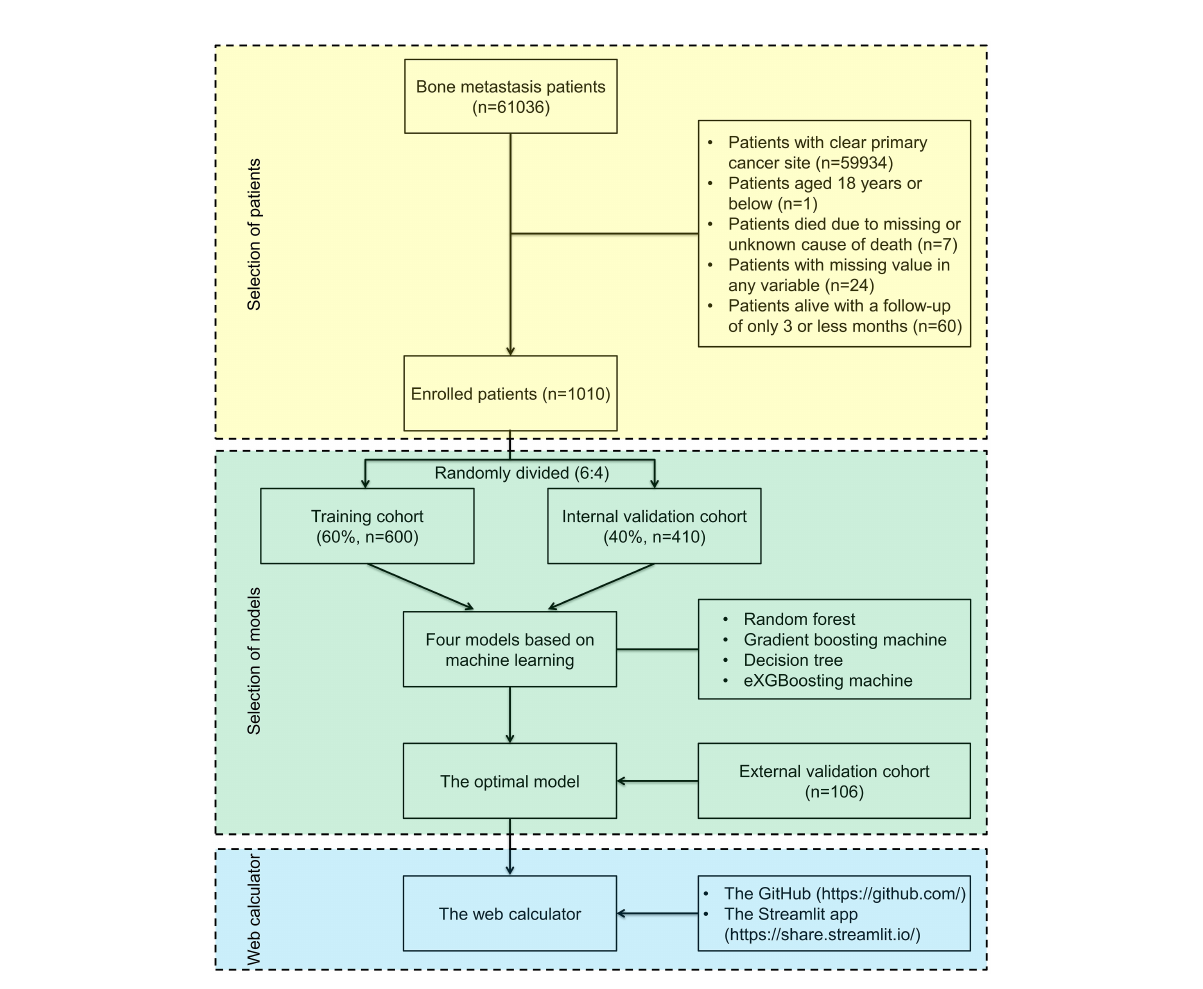
FIGURE 1 Flow diagram outlining patients and methods. The yellow area indicates selection of patients, the green area indicates selection of the optimal machine-learning model in the study, and the blue area indicates establishment of a web-based